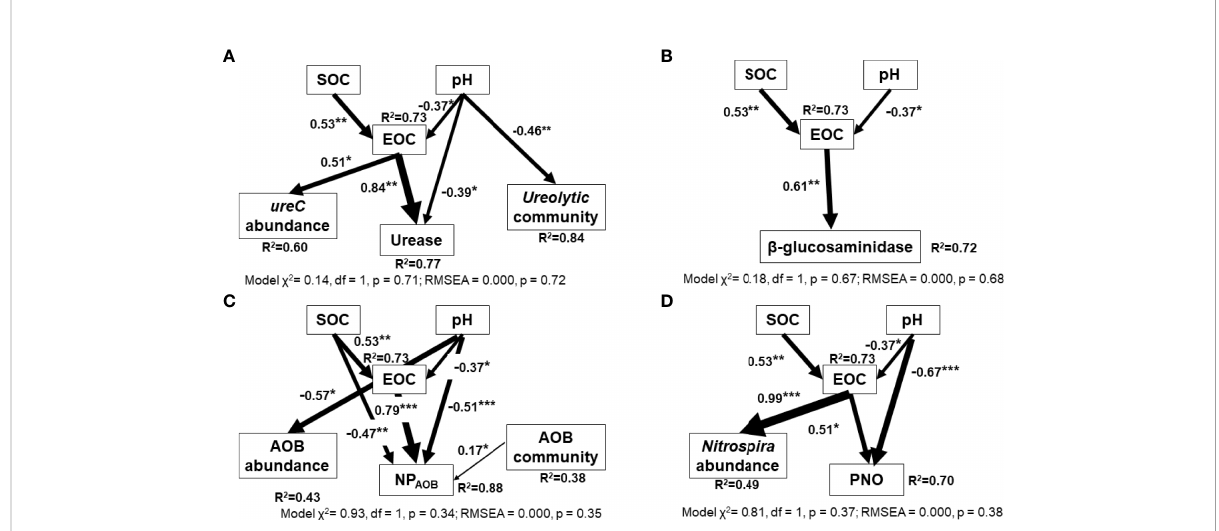
FIGURE 5 Structural equation models (SEM) showing the effect of soil chemical properties (SOC, EOC, and pH) and the abundance and community of N- cycling functional groups on their corresponding N process rates. Four selected N-cycling processes are (A) urease, (B) b -glucosaminidase (NAGase), (C) octyne-sensitive nitri fi cation potential (nitri fi cation potential contributed by AOB, NP AOB ), and (D) potential nitrite oxidation (PNO). NMDS1 is used to represent the community composition of N-cycling functional groups. The arrow width is proportional to the strength of the relationship. R 2 represents the proportion of variance explained for every dependent variable. SOC, soil organic carbon; EOC, extractable organic C. Asterisks indicate signi fi cant p values (***p < 0.001, **p < 0.01, *p <